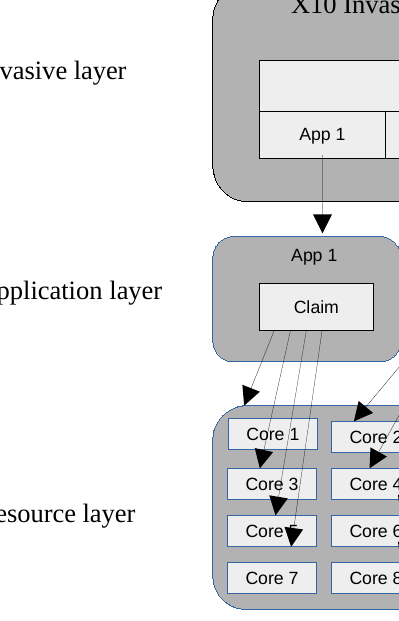
Figure 9. Invasive Malleability—invasive architecture developed whit X10 invasive framework [60]. Based on: https://pp.ipd.kit.edu/uploads/publikationen/bungartz13invasive.pdf (accessed on 13 April 2022). Adapted with permission from [60]. Copyright 2013, Hans-Joachim